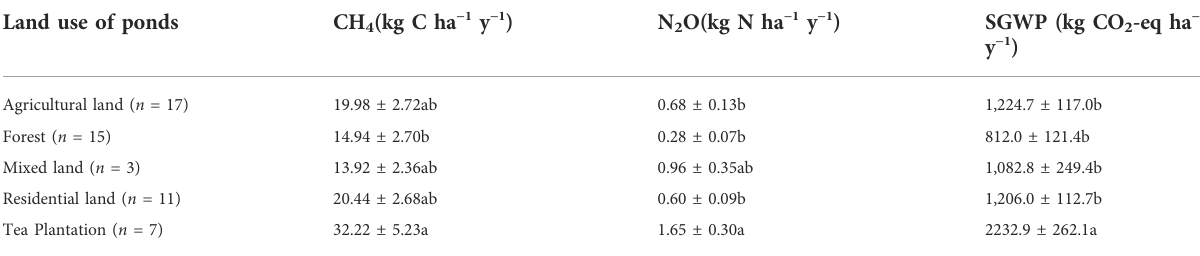
TABLE 2 Annual CH 4 and N 2 O emissions fl uxes and Annual SGWP in different landscape types of